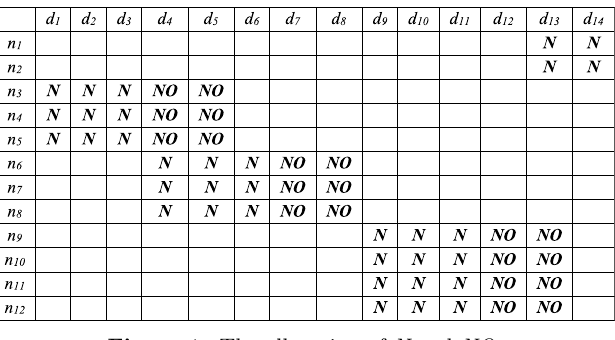
Figure 1. The allocation of N and NO .